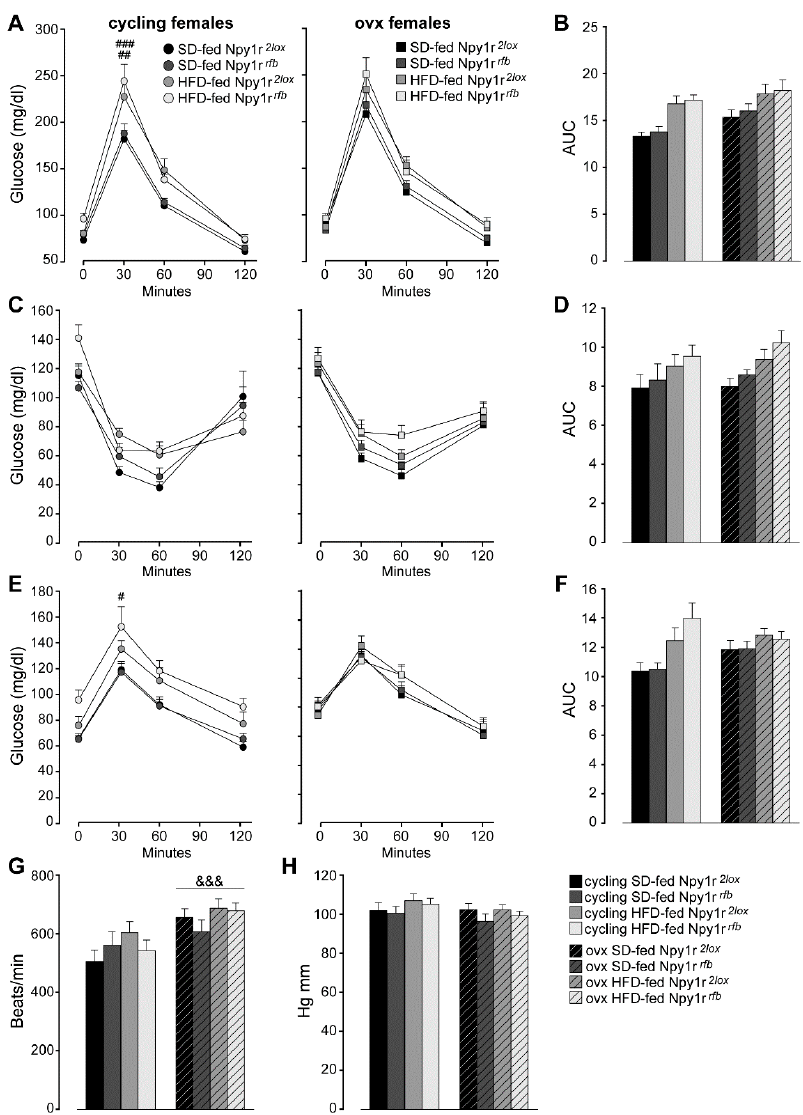
Figure 3. Glucose homeostasis and metabolism of standard diet (SD)- and high-fat diet (HFD)-fed cycling and ovx Npy1r 2lox control and Npy1r rfb knockout female mice ( A – F ). ( A ) Glucose tolerance tests and ( B ) area under the curve (AUC) of SD- and HFD-fed cycling and ovx Npy1r 2lox and Npy1r rfb females. Data are the mean ± SEM; n = 11–20 from 3 litters. ## p < 0.01 HFD-fed versus SD-fed cycling controls; ### p < 0.001 HFD-fed versus SD-fed cycling Npy1r 2lox female mice. ( C ) Insulin tolerance test and ( D ) area under the curve (AUC) of SD- and HFD-fed cycling and ovx Npy1r 2lox and Npy1r rfb females. Data are the mean ± SEM; n = 7–15 from 2 litters. ( E ) Pyruvate tolerance test and ( F ) area under the curve (AUC) of SD- and HFD-fed cycling and ovx Npy1r 2lox and Npy1r rfb females. Data are the mean ± SEM; n = 7–16 from 2 litters. # p < 0.05 HFD-fed versus SD-fed cycling Npy1r rfb females. ( G ) Heart rate and ( H ) blood pressure of standard diet (SD)- and high-fat diet (HFD)-fed cycling and ovx Npy1r 2lox control and Npy1r rfb knockout female mice. &&& p < 0.001 versus cycling females.